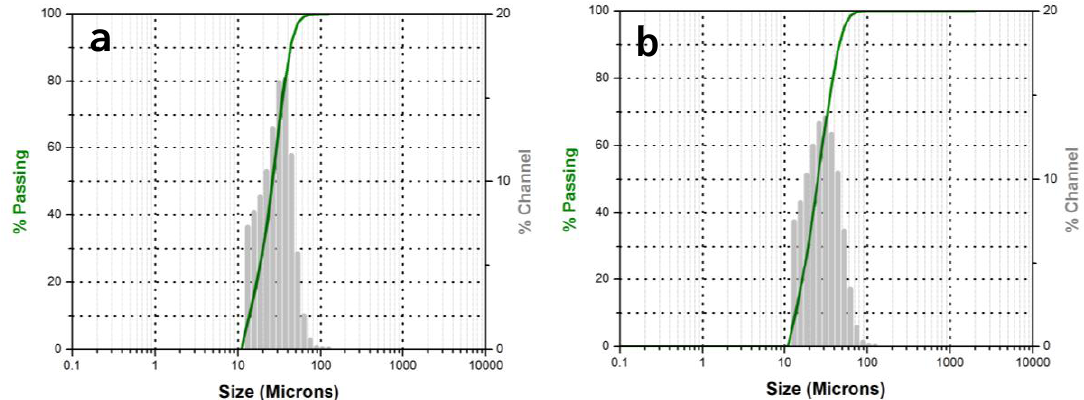
Figure 7. Particle size distributions of ( a ) raw aluminum pigments and ( b ) colored aluminum pigments.